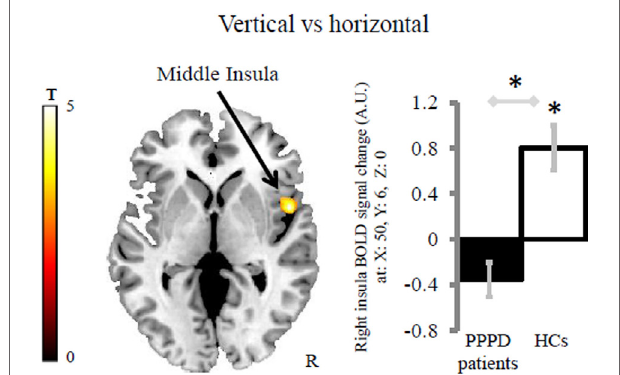
FigUre 2 | Group differences in the brain response for the contrast vertical vs horizontal. Patients with persistent postural-perceptual dizziness (PPPD) displayed less difference of activity in the right middle insula compared with healthy controls (HCs). Asterisks indicates significant results at cluster-wise corrected threshold of p < 0.05 after Monte Carlo simulations within the brain mask including the regions of interest. The coordinates ( x , y , z ) are in the Montreal Neurological Institute space. The color bar represents t -statistics. In the bar graph, bars represent the mean BOLD response of each group extracted from the cluster displayed. Error bars represent the Standard Error. BOLD, blood oxygenation level-dependent signal; A.U., arbitrary unit; R, right